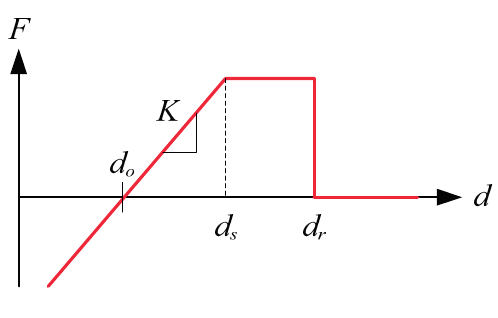
Figure 4. Spring constant